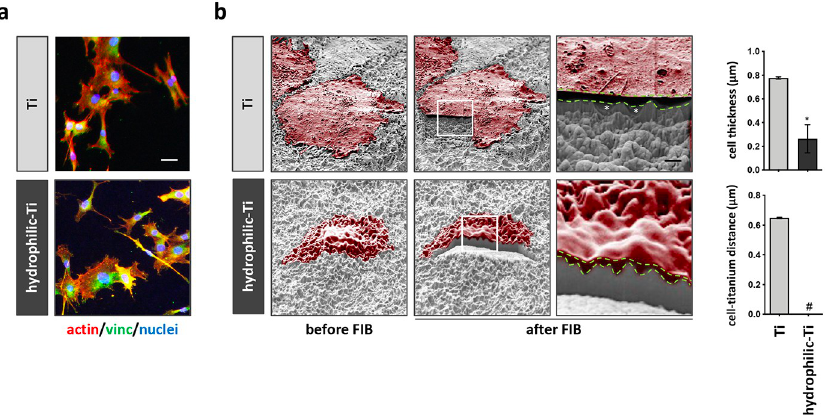
Fig 1. Interface intimate relationship between human MG-63 and microrough titanium implant surfaces with normal or enhanced hydrophilicity. Human MG-63 were cultured on microrough titanium implant surface with standard (Ti) or enhanced hydrophilicity (hydrophilic Ti), thus prepared and analyzed by fluorescence or by SEM-FIB microscopy. ( a ) Immunofluorescence staining for actin (red), vinculin (green) and cell nuclei (blue) reveals the polygonal shape of human MG-63 when cultured on titanium surfaces. Scale bar: 50 μ m. ( b ) SEM images before and after FIB cross-sectioning reveals the shape and the intimate connection established by the cells (red) with the underlying surface by human MG-63. Scale bar: 2 μ m. Scale bar close up: 0.2 μ m. The intimate relationship between cells and titanium was further quantified by measuring cell thickness and the distance occurring between the cell border and titanium. � = p < 0.05. Green dashed lines indicate the top and bottom border of the cells, while white stars indicate air bubbles entrapped between cells and titanium.